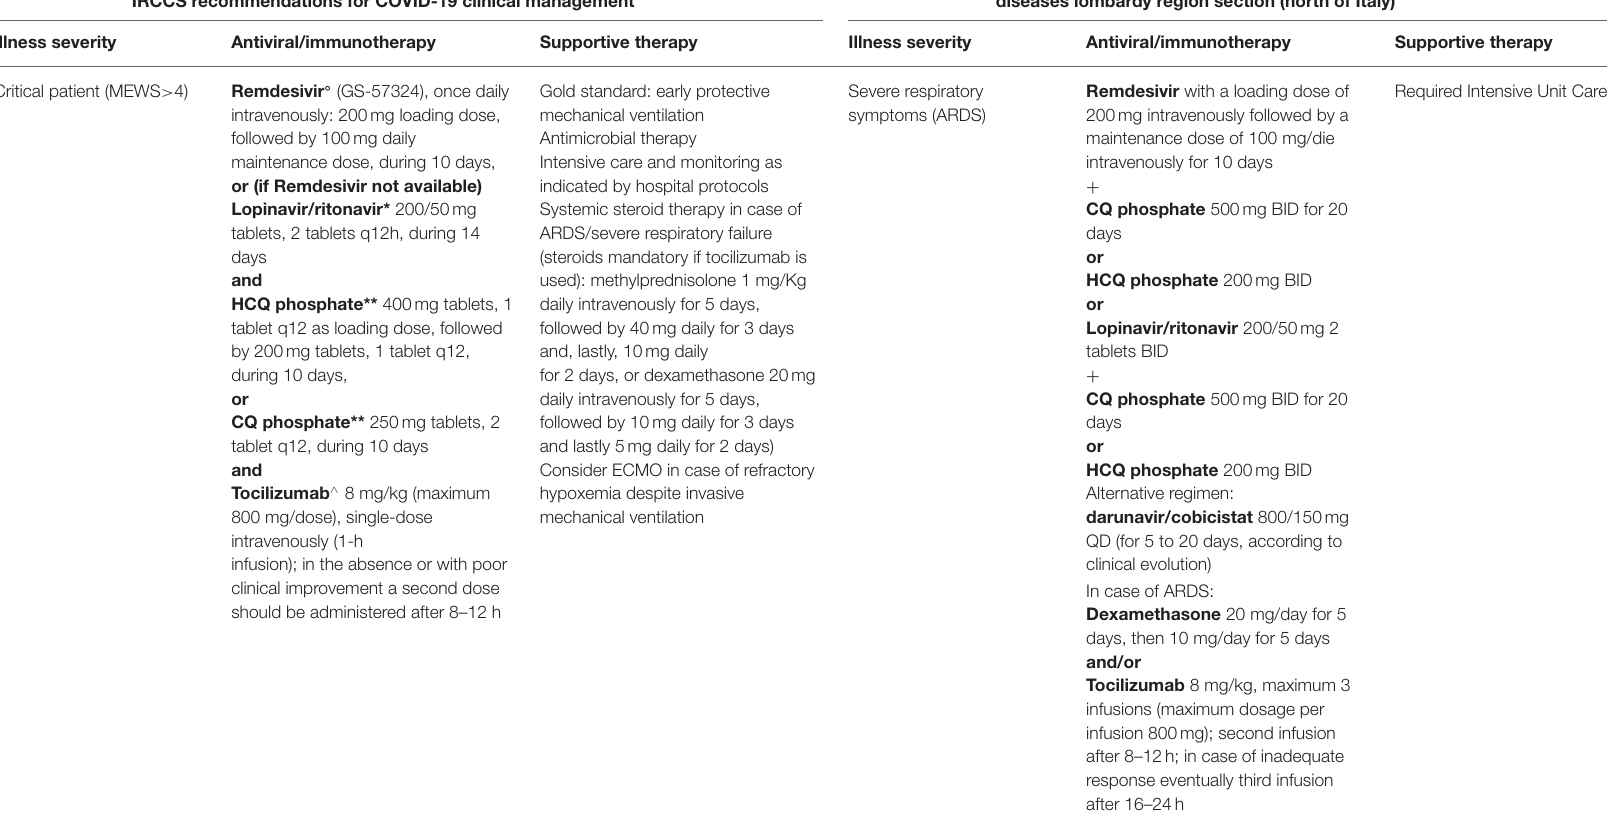
National institute for the infectious diseases “L. Spallanzani”, IRCCS recommendations for COVID-19 clinical management